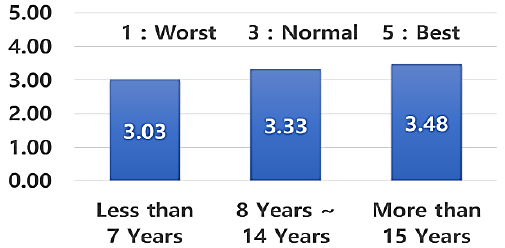
Figure A3. Users’ understanding on the term ‘EVENT’ based on experience of GPS plotter usage. Average (1: Worst to 5: Best).